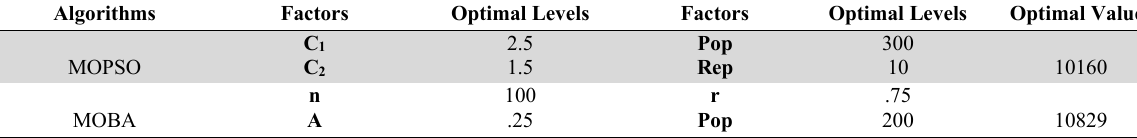
Optimal level of different parameters (raw material inventory model) Algorithms